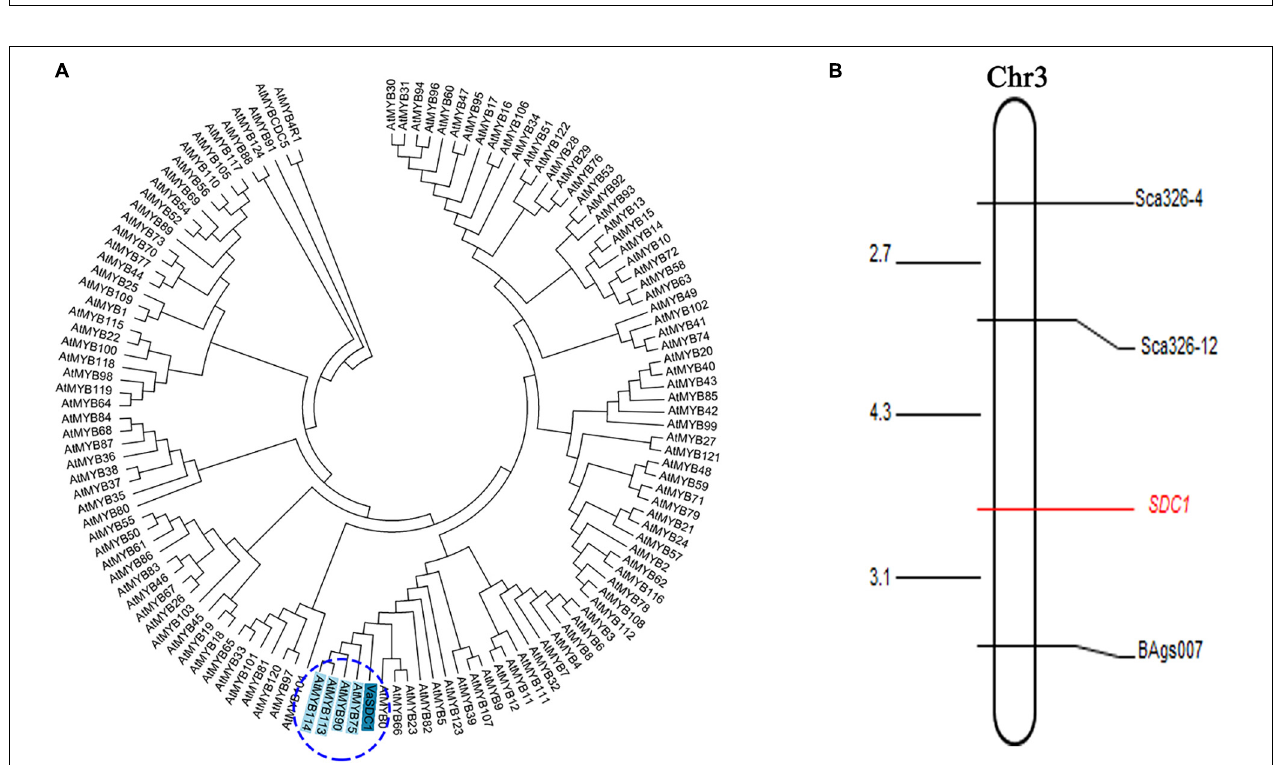
FIGURE 5 | Further proof of the involvement of VaSDC1 in the colouration difference between Jingnong6 and AG118. (A) Neighbour-joining (NJ) phylogenetic tree based on amino acid sequences VaSDC1 and all R2R3-MYBs of Arabidopsis ; (B) linkage map between SDC1and SSR markers.